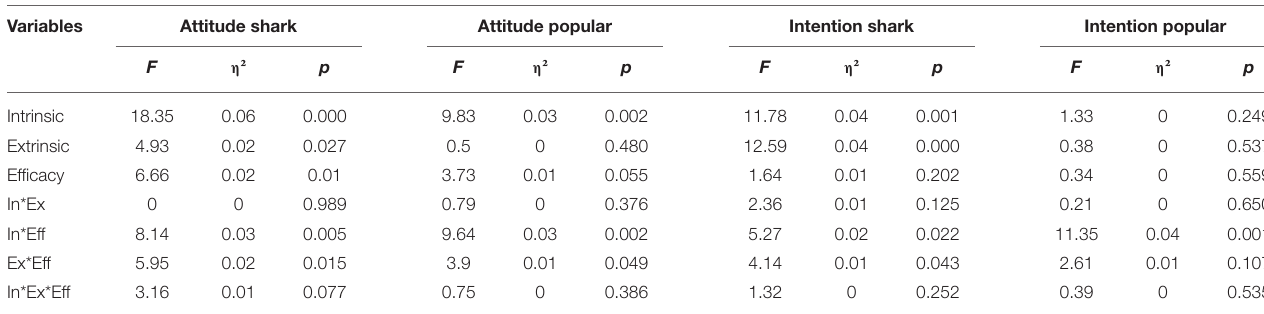
TABLE 3 | Factorial ANOVA for the four main